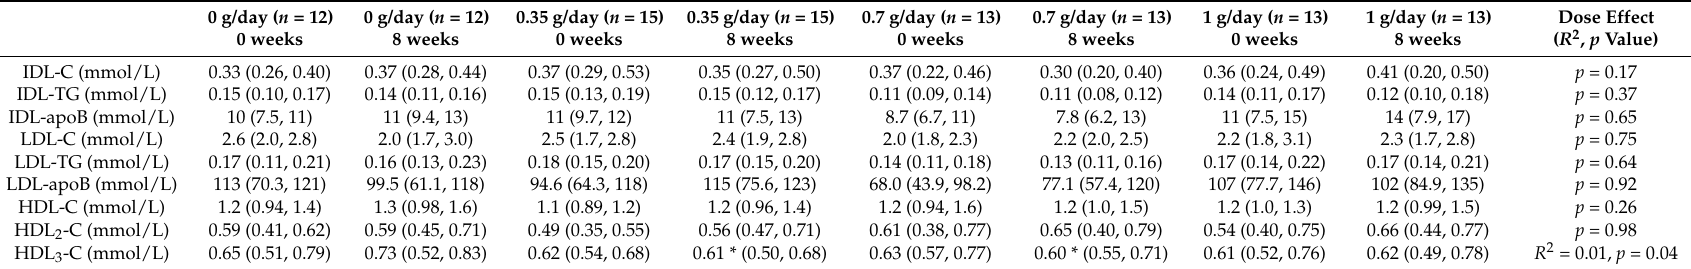
Table 4. Changes in lipoprotein composition following supplementation with 0–1 g/day n -3 LCPUFA from HiDHA™ tuna oil (values median (25th percentile, 75th percentile); n =